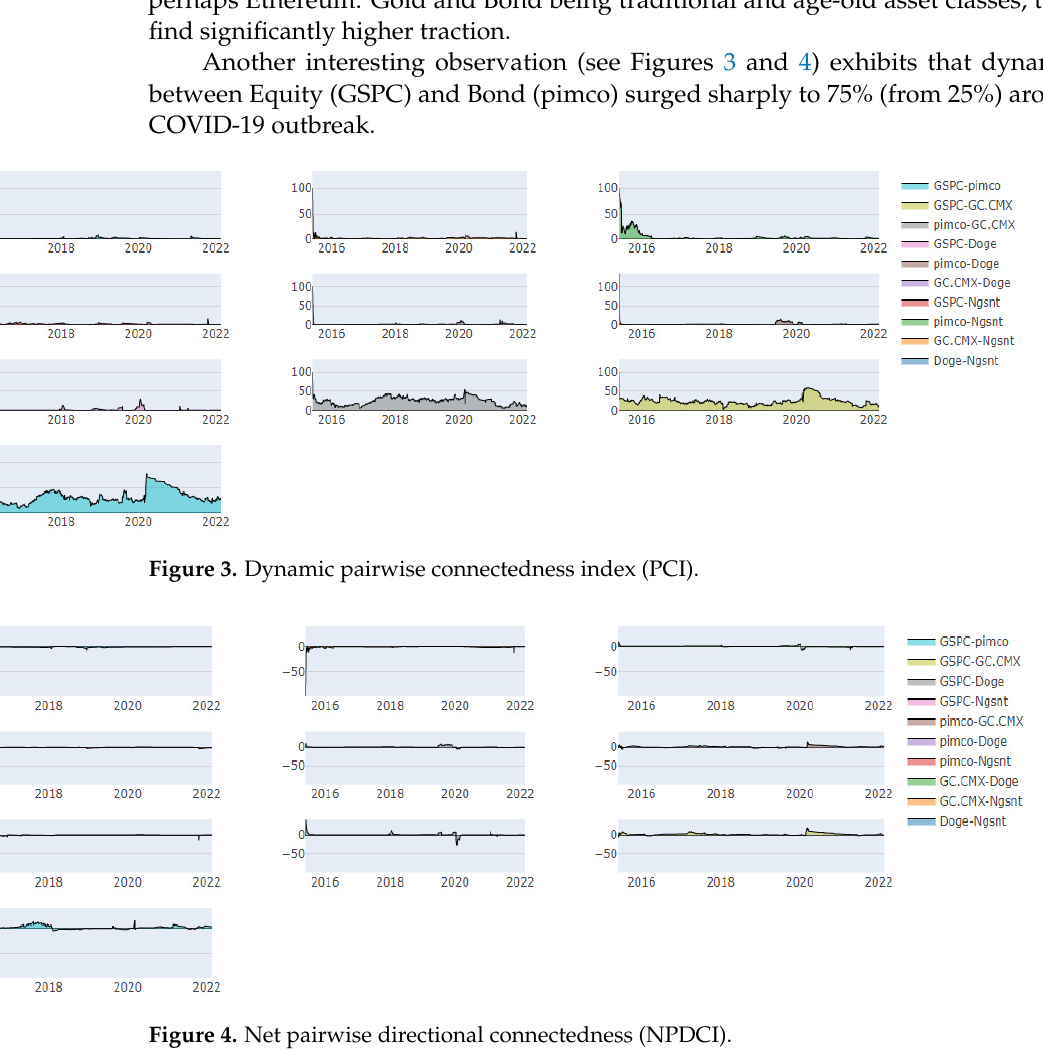
Figure 5. TCI over the years (from June 2015 to February 2022). 5. Conclusive Remarks We found four research queries during our extensive literature review (which is writ- ten all across this paper). First, we wanted to empirically confirm whether Twitter emits negative sentiment. Interestingly, it was found that the Twitter induced negative senti- ment (Ngsnt) was found to be three times stronger net emitter over Equity, which is rep- resented by GSPC (or S&P 500) (see Tables 3 and 5). Second, our query was regarding the negative tweet (Ngsnt) and Dogecoin prices interconnectedness. Their interconnectedness was found to be quite feeble in comparison to other asset classes (see Table 3). The relative newness of Dogecoin over Bitcoin and Ethereum could justify this outcome. Third, we checked whether Gold as a traditional hedge wins over Dogecoin or not. It was found that